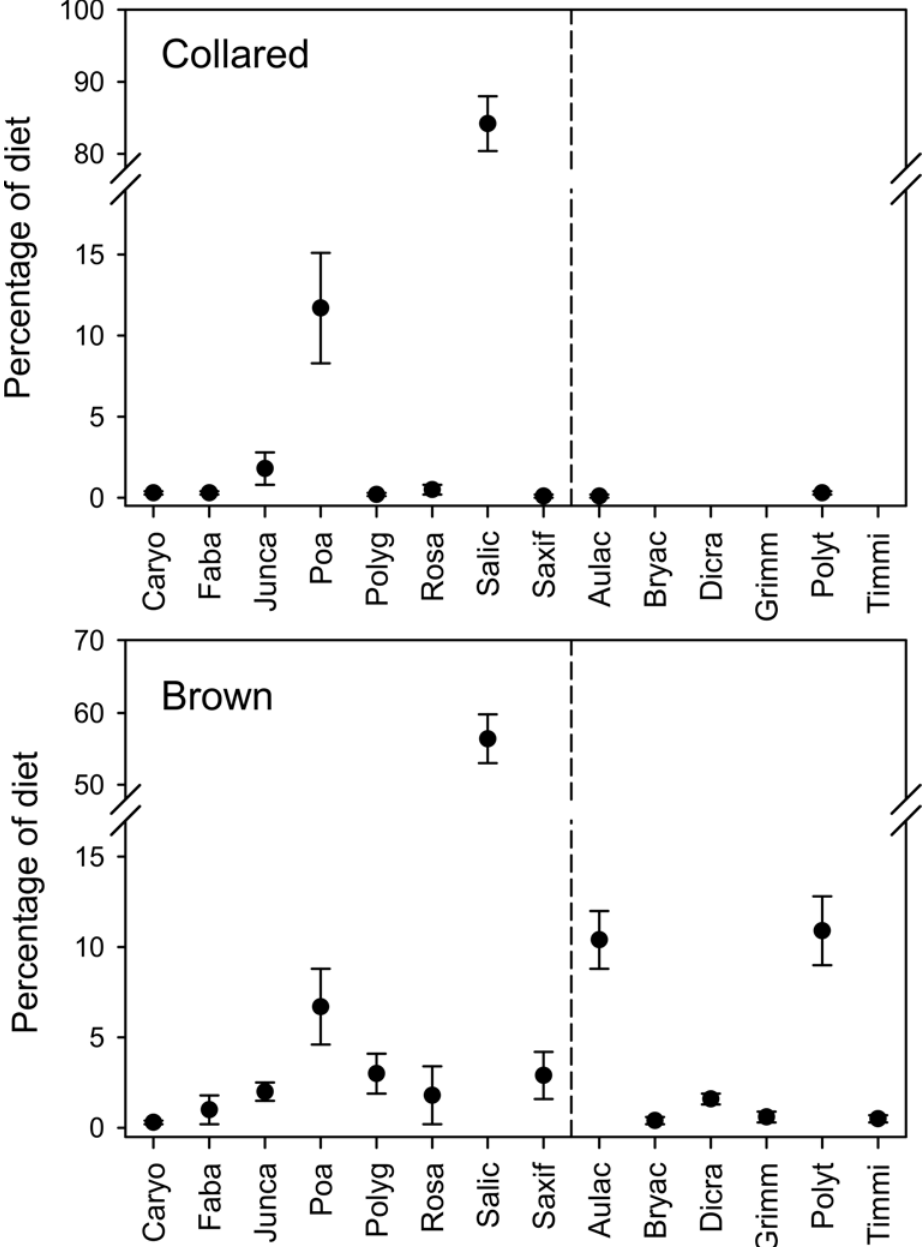
Figure 1. Composition of winter diets of collared and brown lemmings. Diets (mean ± SE) of collared (n = 22) and brown lemming (n = 54) during the winter 2010 – 11 on Bylot Island, Nunavut, Canada, based on DNA metabarcoding sequences extracted from pellets. Vascular plant and moss families are separated by a dashed line. Other or unidentified items accounted for 0.5% and 1.2% of the collared and brown lemming diet, respectively (not shown on graph). Taxa without dot on the graph were not found. Families are Caryophyllaceae (Caryo), Fabaceae (Faba), Juncaceae (Junca), Poaceae (Poa), Polygonaceae (Polyg), Rosaceae (Rosa), Salicaceae (Salic), Saxifragaceae (Saxif), Aulacomniaceae (Aulac), Bryaceae (Bryac), Dicranaceae (Dicra), Grimmiaceae (Grimm), Polytrichaceae (Polyt) and Timmiaceae (Timm).